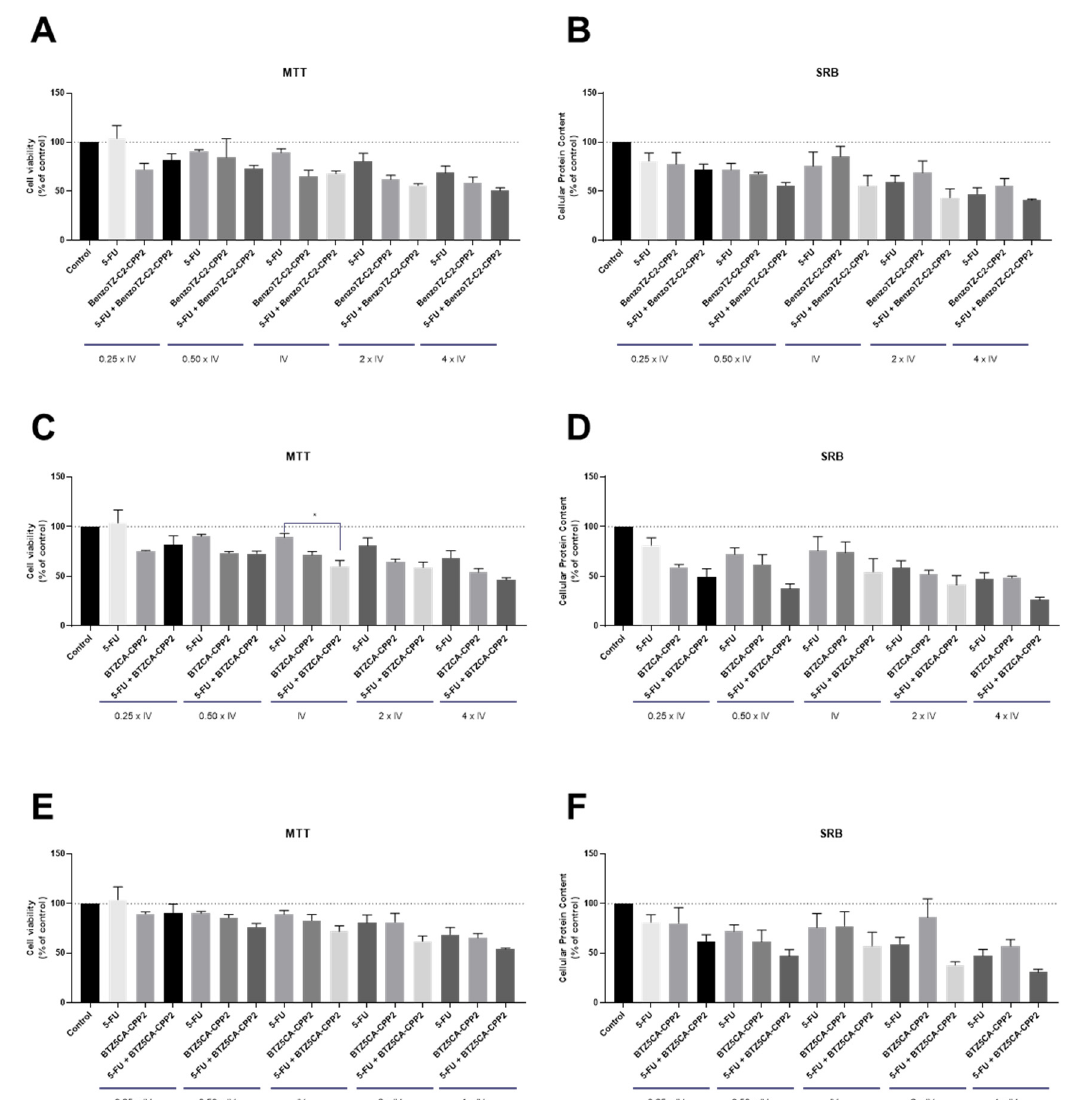
Figure 5. Cytotoxic effects of the combination of 5-FU with ( A , B ) BenzoTZ-C2-CPP2, ( C , D ) BTZCA-CPP2 and ( E , F ) BTZ5CA-CPP2 on the viability (right panel) and cell protein (left panel) content of HT-29 cells. Cell viability and protein content were assessed by MTT and SRB assays, respectively, after 48 h of exposure to each treatment. Results are expressed in the percentage of cell viability relative to untreated control cells. * Indicates p < 0.05 when compared to control. All data are presented as the mean ± SEM of three independent experiments.